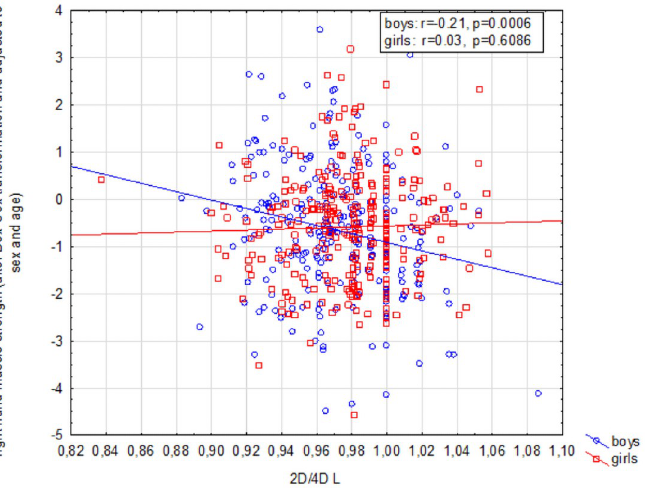
Fig 1. Interaction between 2D:4D L digit ratio and right hand grip strength among children aged